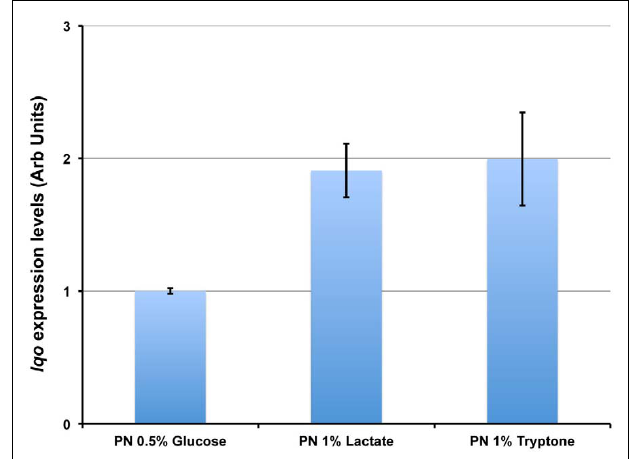
FIGUREA3 | lqo is highly expressed under a variety of culture conditions. Total RNA was extracted from S. aureus strain COL grown in chemically defined medium with either 0.5% Glucose, 1.0% L-lactate, or 1.0% tryptone as primary carbon sources. Quantitative RT-PCR was performed using primers specific for lqo and transcript levels were normalized to rpoD . Data are depicted relative to lqo transcript levels from cells grown on